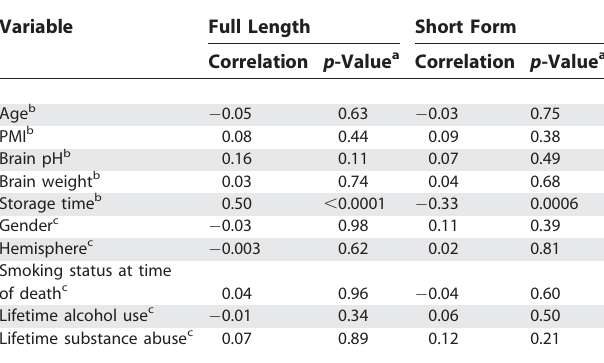
Table 1. Correlations between CAPON Isoform Expression